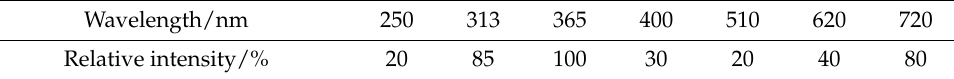
Figure 4. Diagram of photochemical reaction device. Table 2. Spectral distribution and relative intensity of high-pressure mercury lamp.